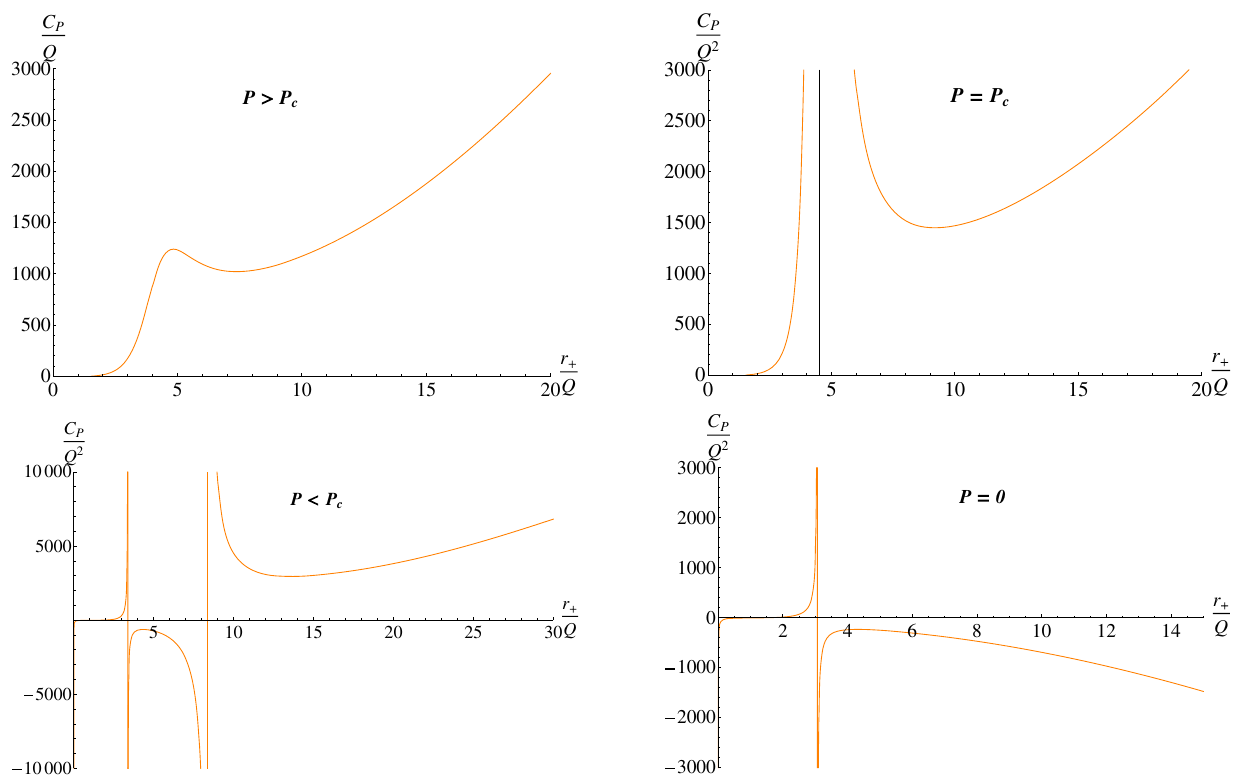
Fig. 6 Plots of the reduced heat capacity C P / Q 2 in terms of the reduced horizon radius r + / Q under the different values of the pressure. They correspond to l / Q = 10 (top left), l / Q ≈ 11.5637 (top right), l / Q = 15 (bottom left), and l / Q → ∞ (bottom right)